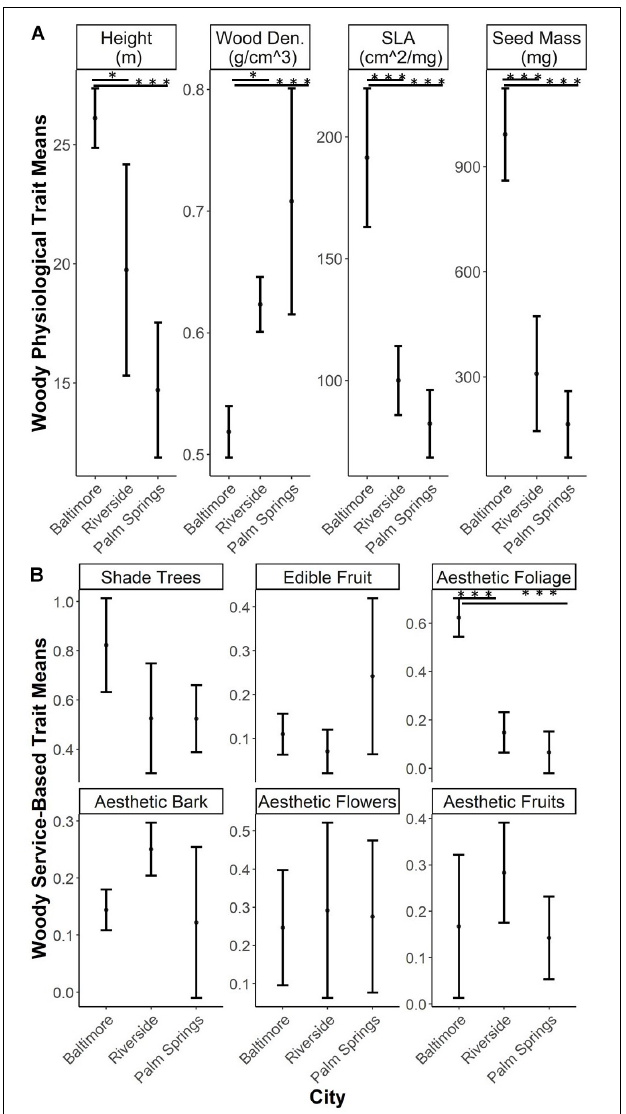
FIGURE 4 | CWM of ecophysiological traits of herbaceous, turf, and spontaneous species (mean and standard deviation). Asterix refer to significant differences between groups tested through ANOVA with a post hoc Tukey HSD test ( ∗ p < 0.05, ∗∗ p < 0.001, ∗∗∗ p < 0.0001). Observe that y -axis varies for each trait